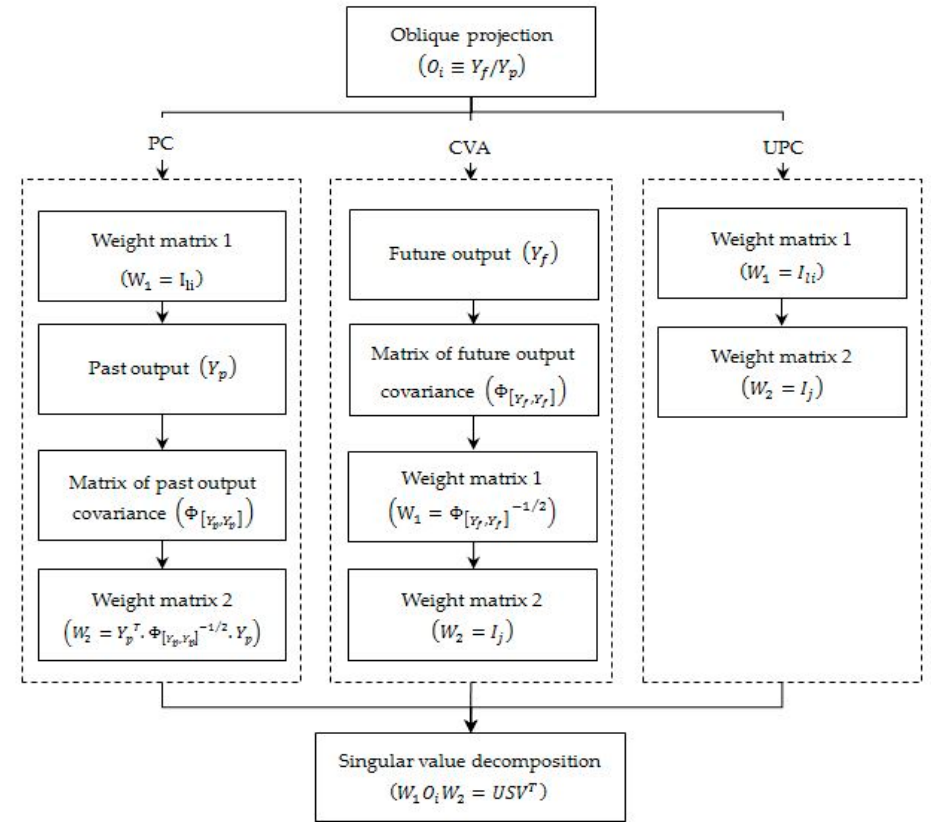
Figure 2. The flowchart to calculate principle component (PC), unweighted principle component (UPC), and canonical variate analysis (CVA) weight matrices.